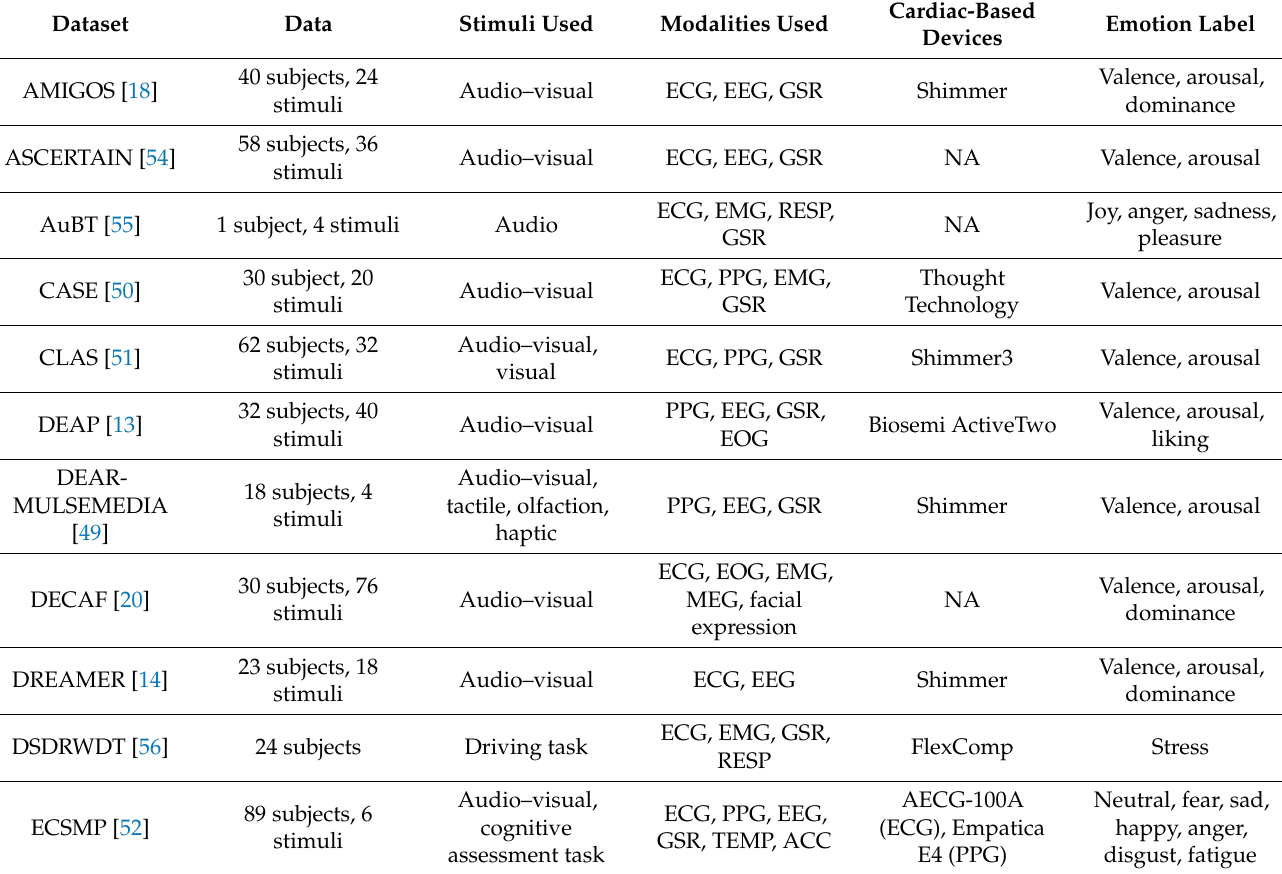
Table 1. Summary of the existing cardiological-based ERS